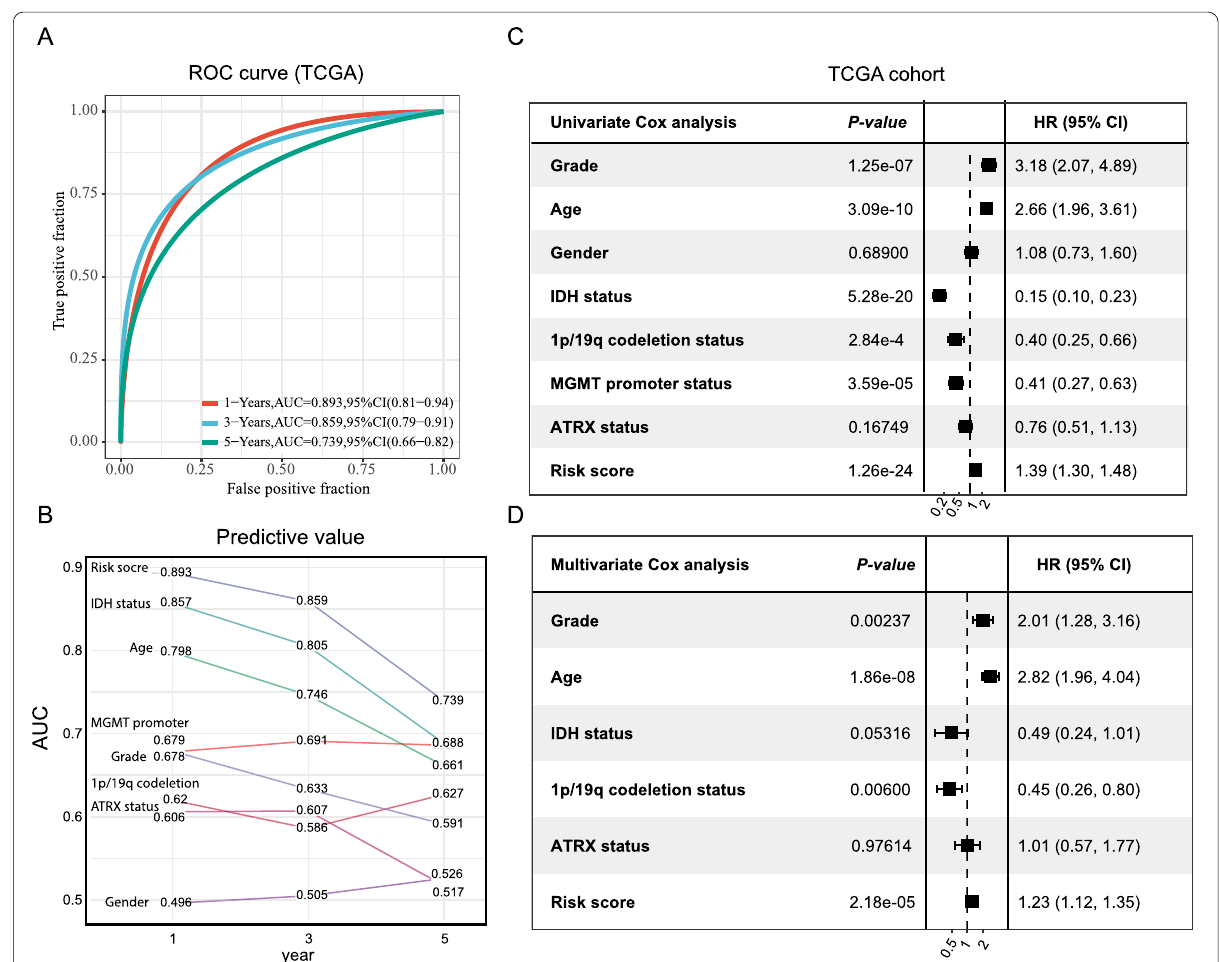
Fig. 7 Prognostic value of the inflammation-related risk signatures in LGG. A ROC curve showing the predictive value of inflammation risk signature for 1-, 3-, and 5-year survival rates. B Comparison of predictive value between inflammation risk signature and clinicopathologic features. C and D Univariate Cox ( C ) and multivariate Cox analyses ( D ). Evaluating the independent prognostic value of the inflammation risk signature in terms of